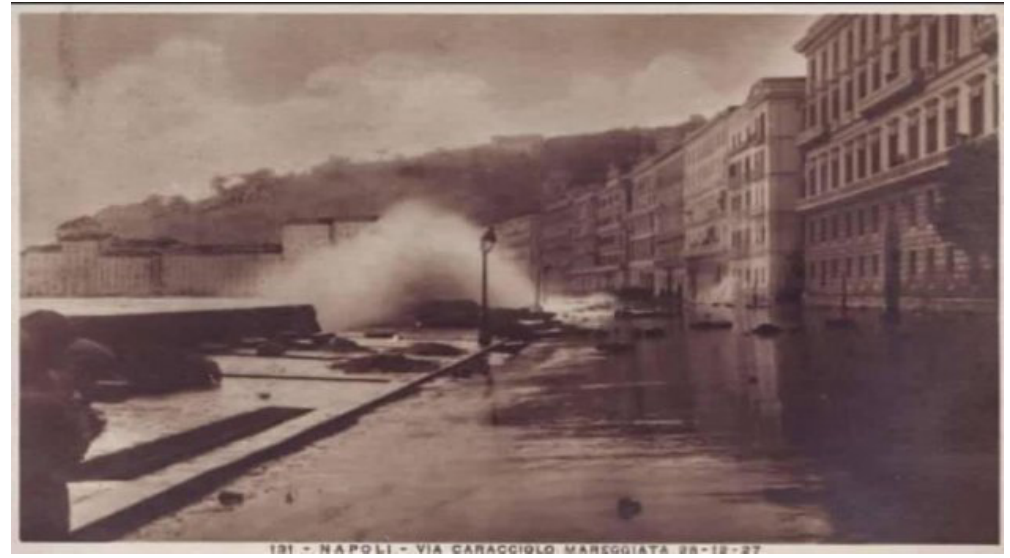
Figure 13. Historical photo of the 1927 storm that impacted and destroyed via Caracciolo, Naples (from the Il Mattino